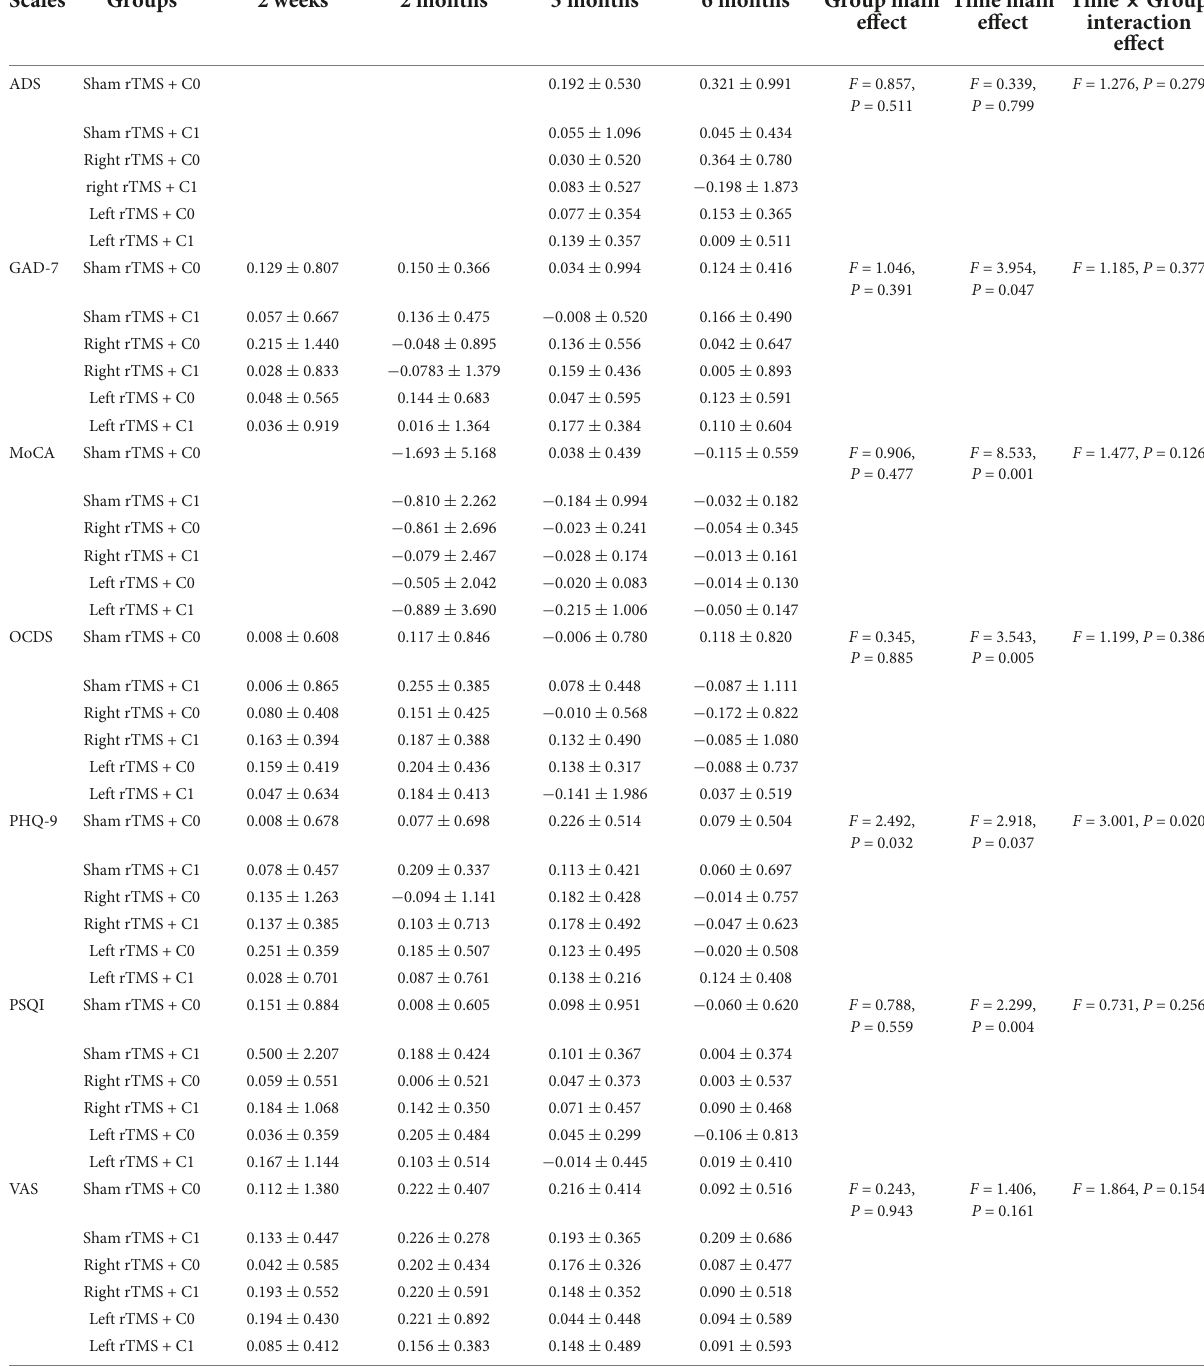
TABLE 3 Repeated measures ANOVA for the rate of scale score reduction in the six groups of patients after 2 weeks, 2 months, 3 months, and 6 months of follow-up. Scales